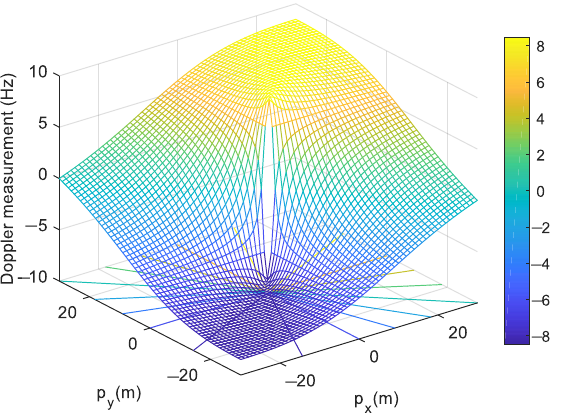
Figure 1. Contour plot of the Doppler measurement with a constant velocity ˙ p x = ˙ p y = 1 m/s and the sensor located at position s x = s y = 0